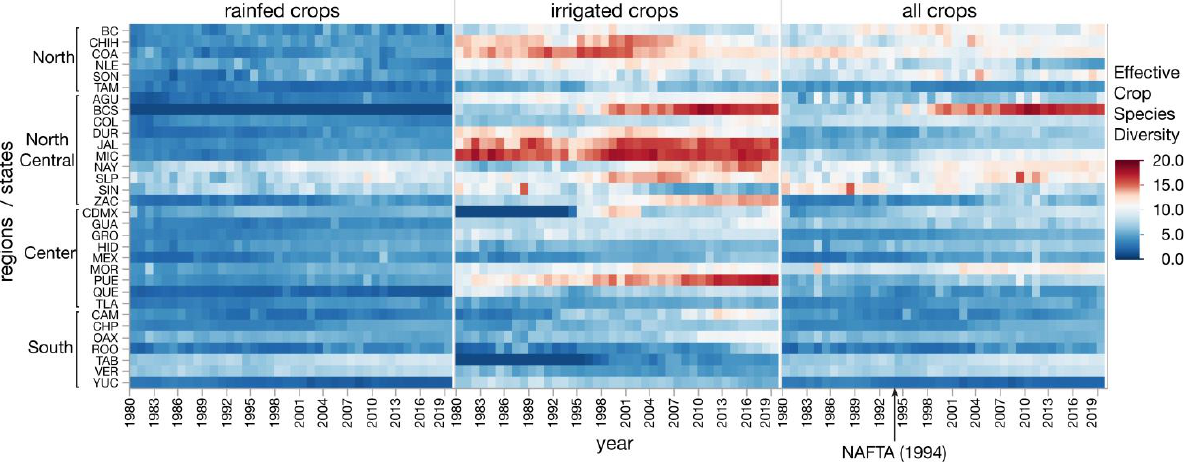
Figure 4. Heat chart of changes in effective crop species diversity (D) from 1980 to 2019 by states and regions of Mexico, stratified by rainfed, irrigated, and all crops.